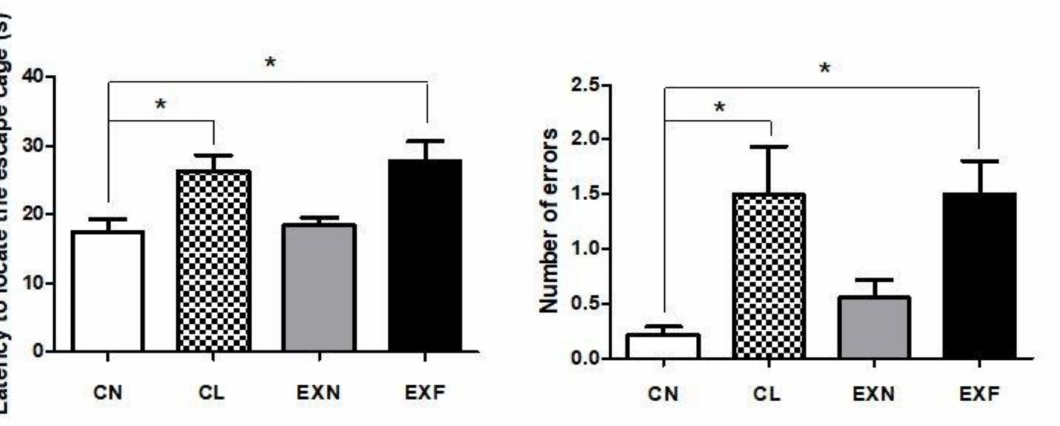
Figure 7. The latency to find the target hole (s, left) and number of reference errors (entering the incorrect hole, right) in mice with various body conditions. Abbreviations: (CN) control group of mice characterized by normal weight and physiological percentage of body fat deposits; (CL) control group of mice characterized by reduced weight and reduced body fat deposits; (EXN) experimental group of mice characterized by normal weight and moderately elevated body fat deposits; (EXF) experimental group of mice characterized by markedly elevated weight and body fat deposits. Statistical significance of differences between experimental and control groups: * p ≤ 0.05. Data are shown as mean ±